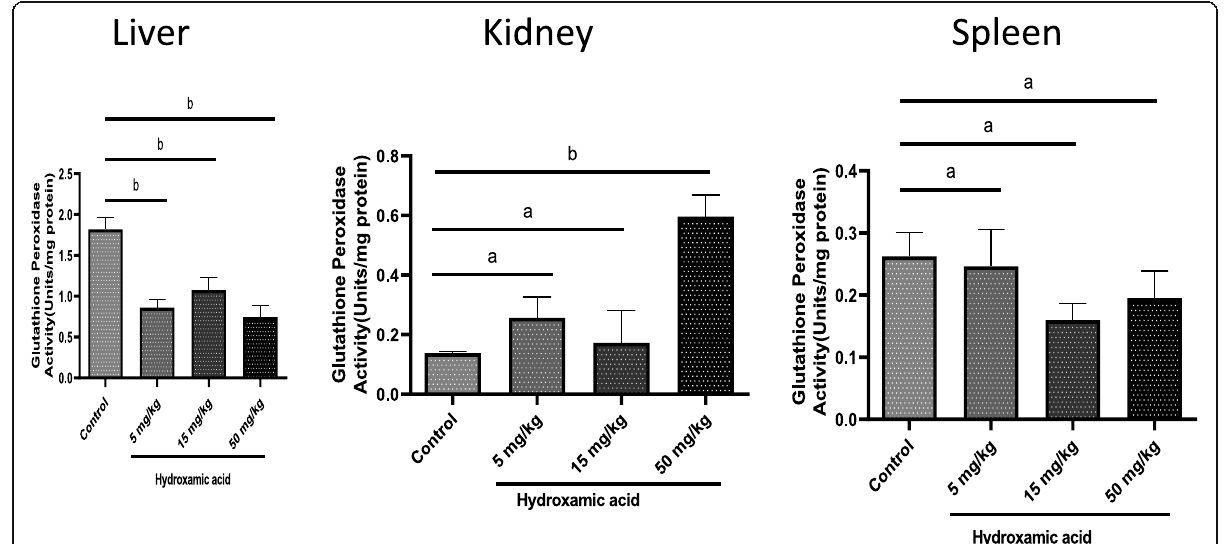
Fig. 3 Glutathione peroxidase activity in liver, kidney, and spleen. Values are expressed as mean ± SEM; ( n = 5).Different letters indicate significant difference at p < 0.05